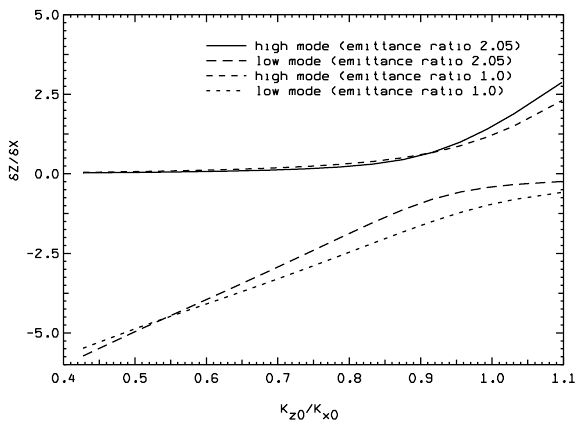
FIG. 6. The ratio of relative amplitude of longitudinal oscilla- tion to that of transverse oscillation, d R z (cid:1) d R x , as a function of the focusing strength ratio k z 0 (cid:1) k x 0 .